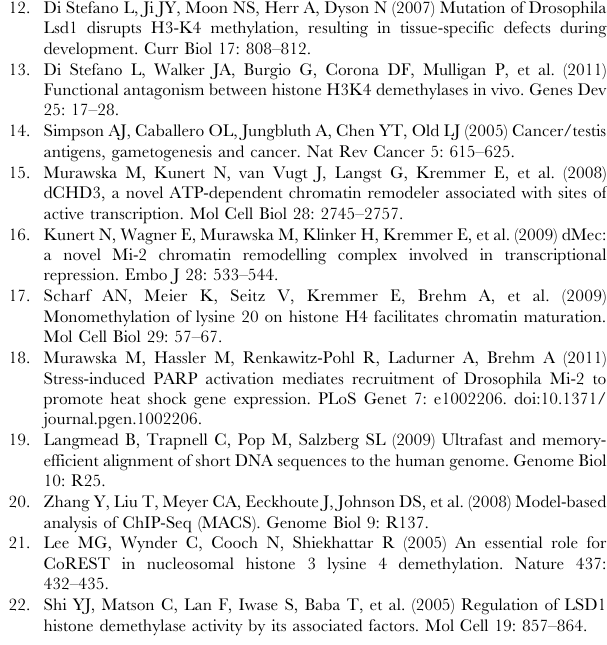
Figure S3 dLint1 interacting proteins coimmunoprecipitate from embryo extracts. Nuclear extracts from 0 to 12 hr old Drosophila embryos were precipitated with protein G beads (beads control, lane 3) and beads loaded with dLint-1 # 1 antibody (lane 2) and analyzed by Western blot as indicated (lanes 2 and 3). dMi- 2 served as a negative control. Lane 1: 5% input; lane 4 contains dLint-1 antibody (antibody control). Figure S4 Comparison of dLint1 ChIP-Seq peaks obtained from two different cell lines. Peaks identified in either S2 or Kc ChIP- Seq data were merged. For each resulting region (possibly spawning multiple peaks) tag count normalized to one million reads was log 2 transformed and plotted. Color indicates whether a region was called by MACS in S2 (green), Kc (blue) or both conditions (red). Figure S5 dLint-1 peaks cluster around TSSs. (A) Approxi- mately 58% of dLint-1 peaks identified in S2 cells overlap with a known transcription start site (TSS). (B) Histogram depicting the distribution of distances from dLint1 peak summits (i.e. region of highest signal intensity) to the next TSS. Distances above 1000 bp were truncated to 1000 bp. Figure S6 LINT target promoters are devoid of H4K20 mono- methylation. Chromatin from cells treated with RNAi against